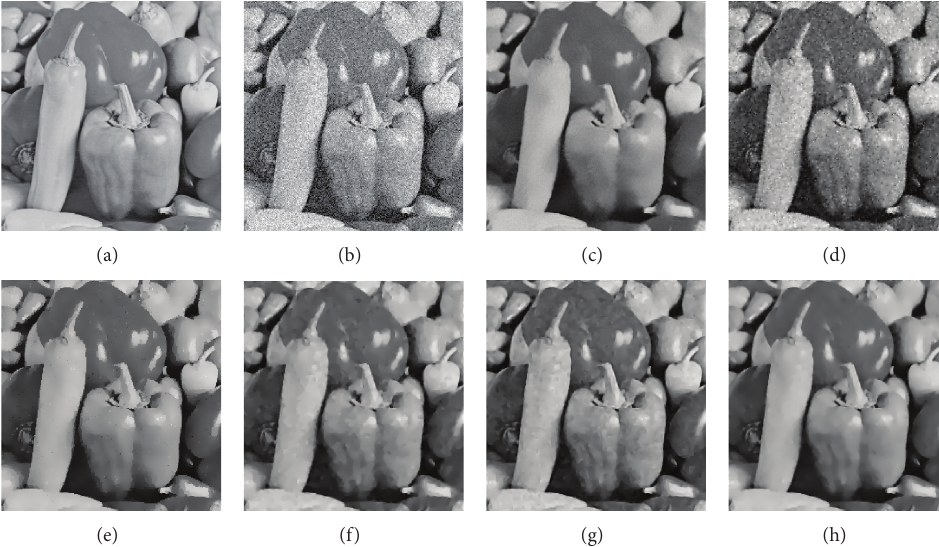
Figure 4: Results of the peppers image by the five models: (a) original image, (b) noisy image, (c) result by NLM, (d) result by Y-K model, (e) result by PM, (f) result by TV, (g) result by MTV, and (h) result by our model.